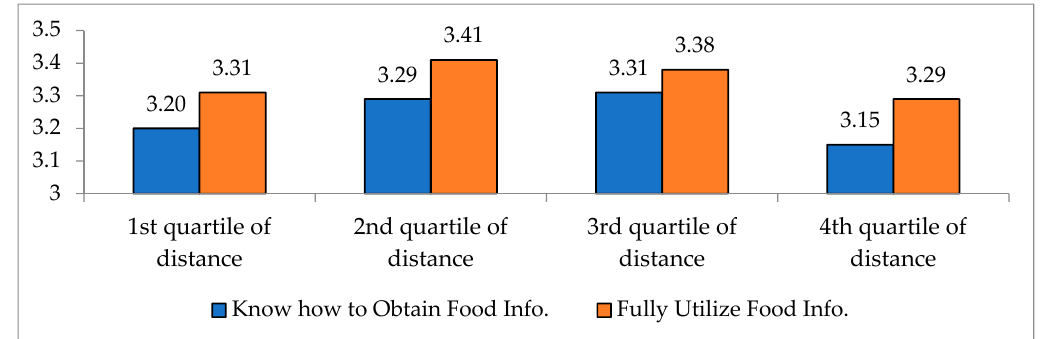
Figure 9. Acquisition and utilization of food-related information by quartile of distance to the nearest grocery store. Note: p -value = 0.000 in t-test Source: Consumer Behavior Survey for Foods [38].